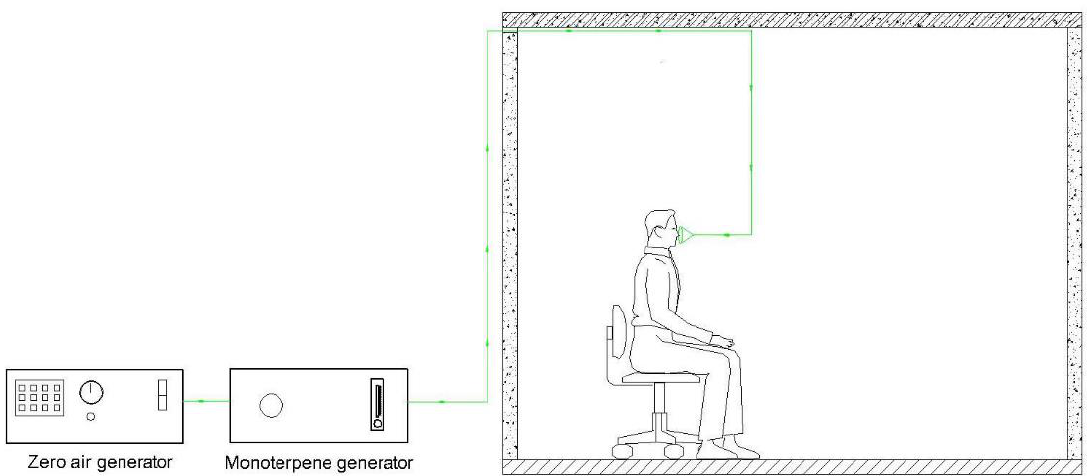
Figure 1. Experimental scheme for monoterpene (MT) exposure in Exps 1 and 2.